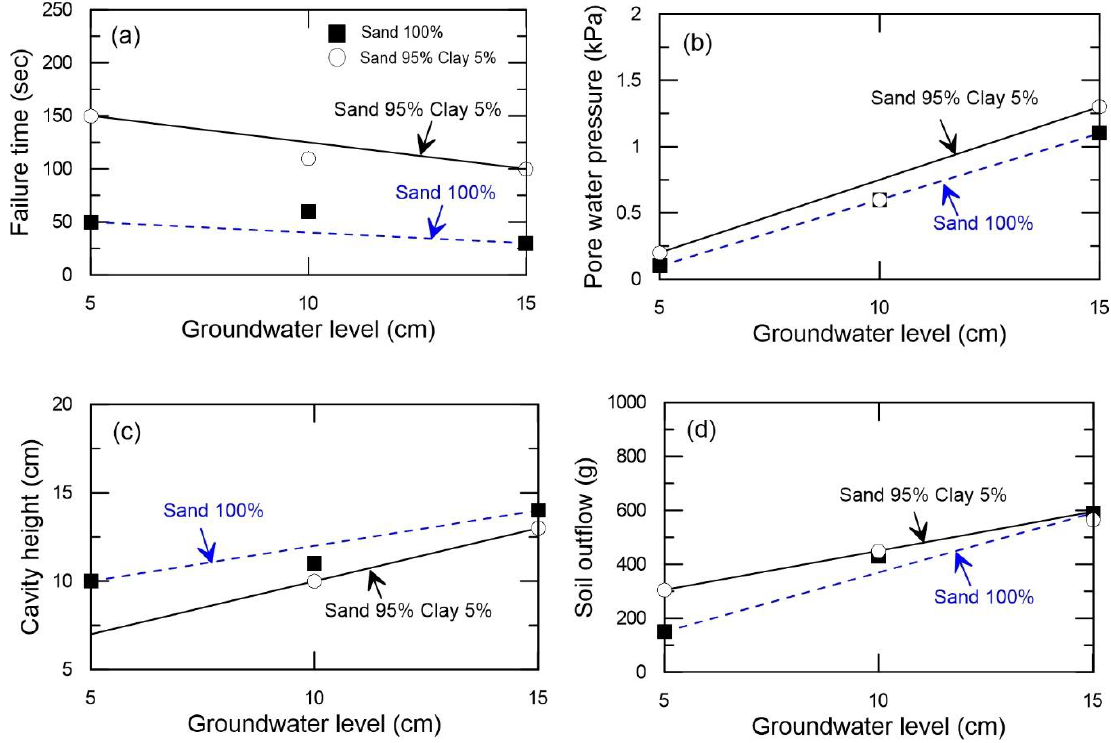
Figure 4. Sinkhole characteristics as a function of clay content: ( a ) failure time; ( b ) pore water pressure; ( c ) cavity height; ( d ) soil outflow.